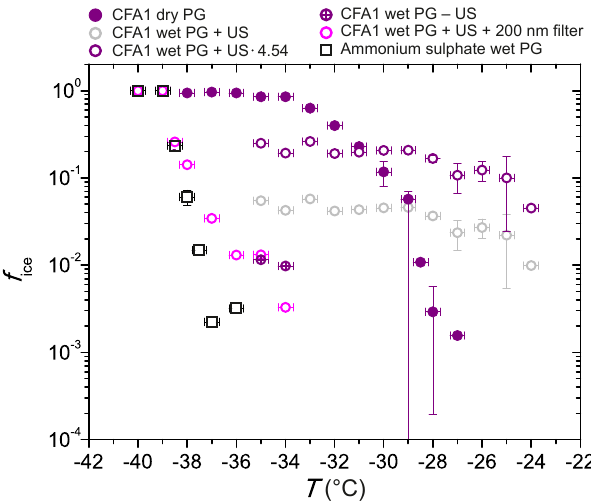
Figure B1. Data taken from Fig. 4d of Grawe et al. (2016) showing f ice measured with 300nm dry- and wet-generated CFA1 particles. US: ultrasonification, PG: particle